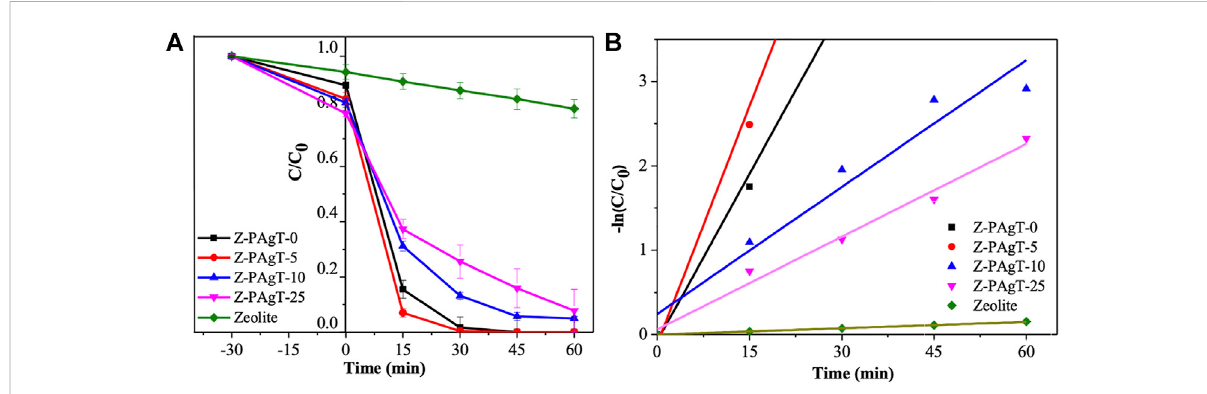
FIGURE 7 (A) Degradation rate and (B) fi rst-order kinetic result of Rh B by zeolite modi fi ed PAgT composites with different wt% zeolite addition under simulated solar light